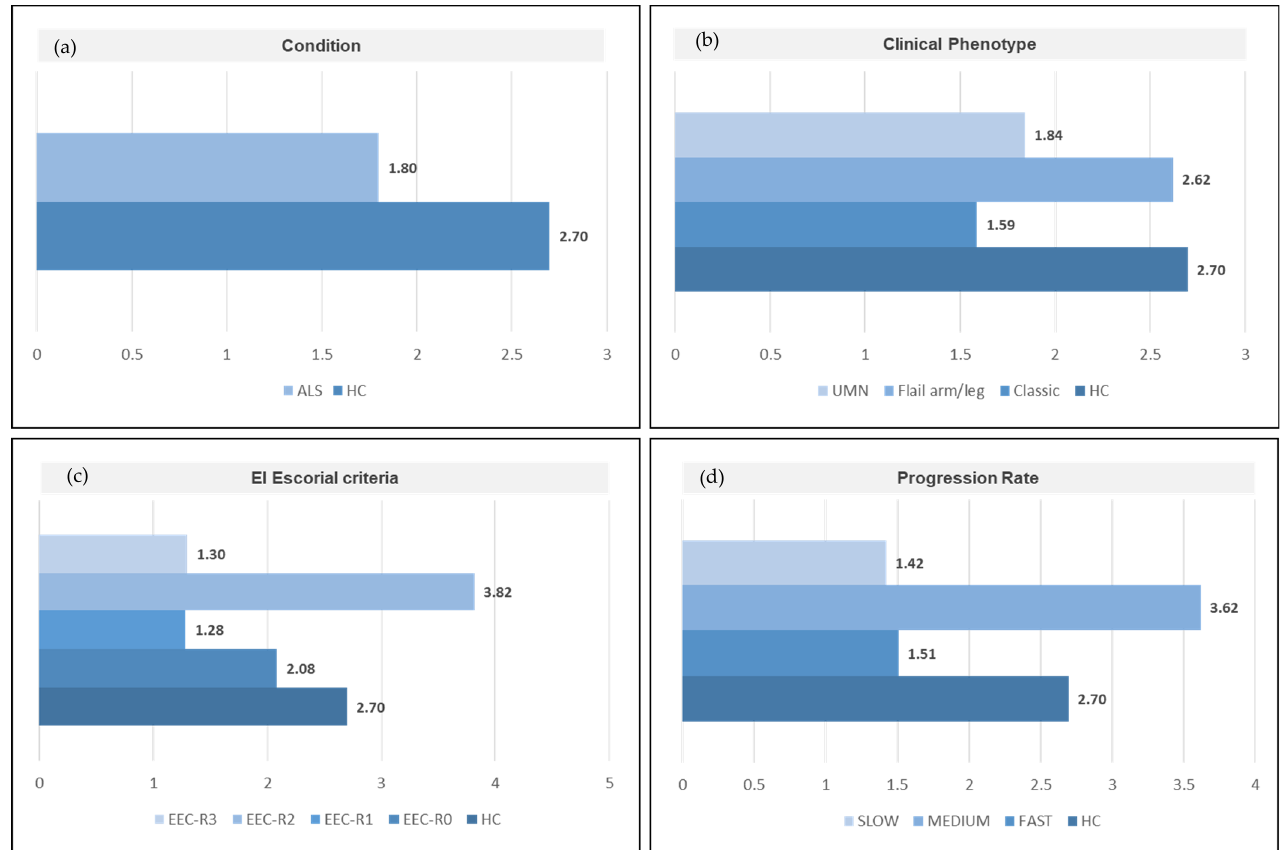
Figure 3 . Differences in the Firmicutes to Bacteroidetes ratio according to ( a ) condition (ALS patients vs. healthy controls), ( b ) ALS clinical phenotype; ( c ) El Escorial Criteria; ( d ) rate of ALS progression. ALS= amyotrophic lateral sclerosis. HC= healthy controls. EEC = EL Escorial Criteria; EEC-R0 = definite; EEC-R1 = clinically probable; EEC-R2 = probable-laboratory-supported; EEC-R3 = possible. Bp = Bulbar phenotype; Cp = Classic phenotype; Fp = Flail arm/leg phenotype; UMNp = Upper Motor Neuron predominant phenotypes.